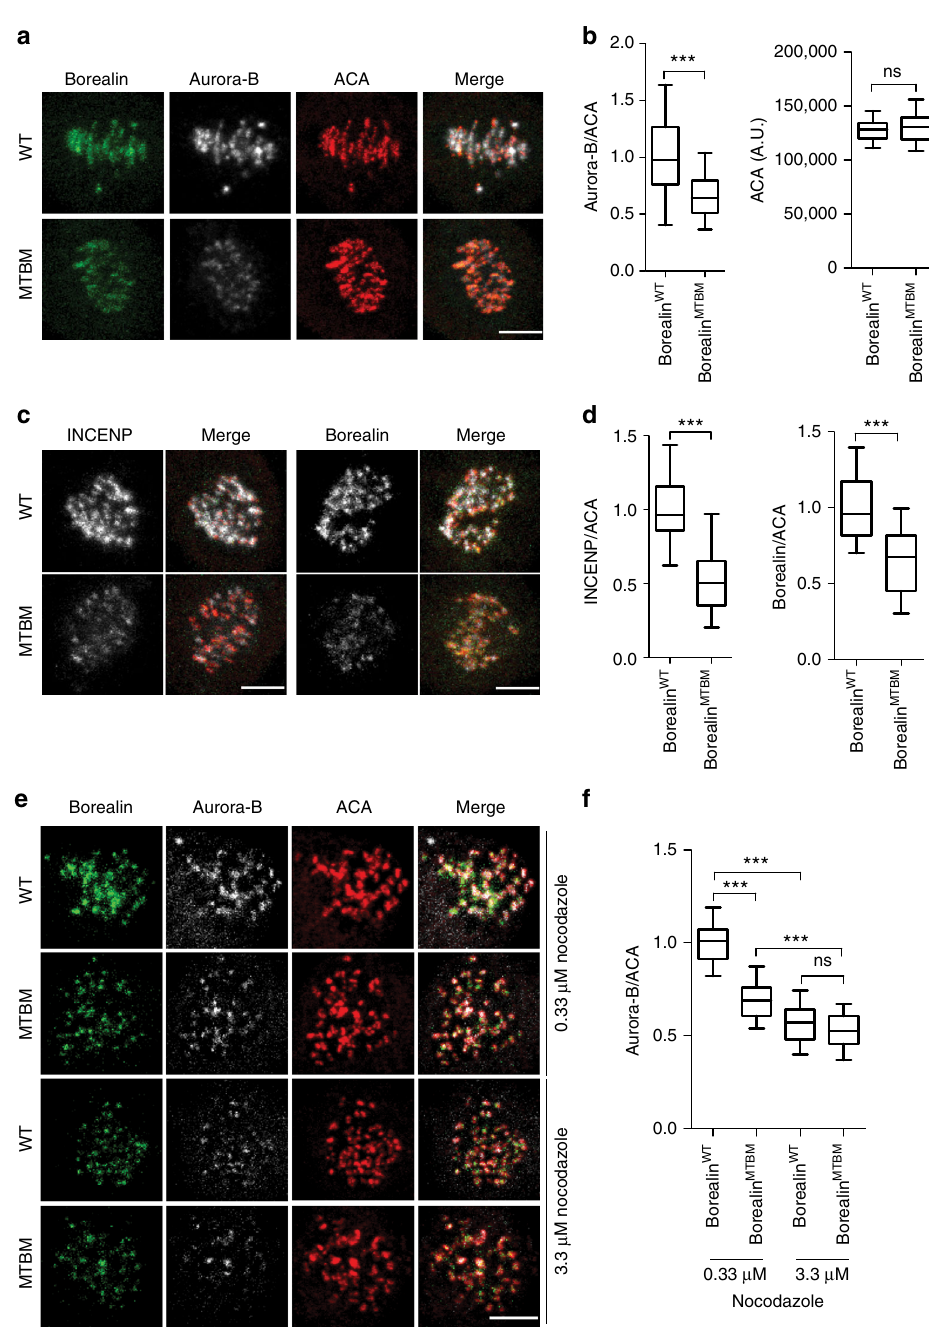
Fig. 6 Borealin-microtubule interaction drives microtubule-dependent enhancement of the CPC localization to the inner-centromere. HeLa-TReX cells expressing LAP-Borealin WT or MTBM were treated with siRNA as described in Fig. 2a, and immunostained with ACA and Aurora-B ( a ) or Borealin ( c ) or INCENP ( c ) antibodies. b Box and whisker plots of Aurora-B intensity normalized to ACA ( P < 0.0001) and absolute ACA intensity ( P = 0.1396), Unpaired T -test with Welch's correction was applied ( n = 94 for WT and n = 110 for MTBM) (representative images in a and quantitation in b from 9 cells per condition, from one of three independent replicates). d Box and whisker plots of INCENP ( P < 0.0001) ( n = 84 for WT and n = 110 for MTBM) and Borealin ( P < 0.0001) ( n = 78 for WT and n = 76 for MTBM) intensity normalized to ACA (representative images in c and quantitation in d from eight cells per condition from one of two independent replicates). Statistical analysis was performed using Mann Whitney Test. e HeLa-TReX cells expressing LAP- Borealin WT or MTBM were treated as described in Fig. 2a, and incubated with either 0.33 μ M or 3.3 μ M nocodazole for 45 min followed by immunostaining with ACA and Aurora-B. f Box and whisker of Aurora-B intensity normalized to ACA ( n = 85 for WT and n = 167 for MTBM in 0.33 nocodazole) ( n = 140 for WT and n = 100 for MTBM in 3.3 μ M Nocodazole) (representative images in e and quantitation data in f from one of two independent replicates with eight cells analyzed per condition). Statistics performed using Dunn's Multiple Comparison Test, *** P < 0.001; ** P < 0.01, * P < 0.05 and ns P > 0.05. All Box and whisker plots represent the median (central line), 25th – 75th percentile (bounds of the box) and 5th – 95th percentile (whiskers). Scale bar is 5 μ m